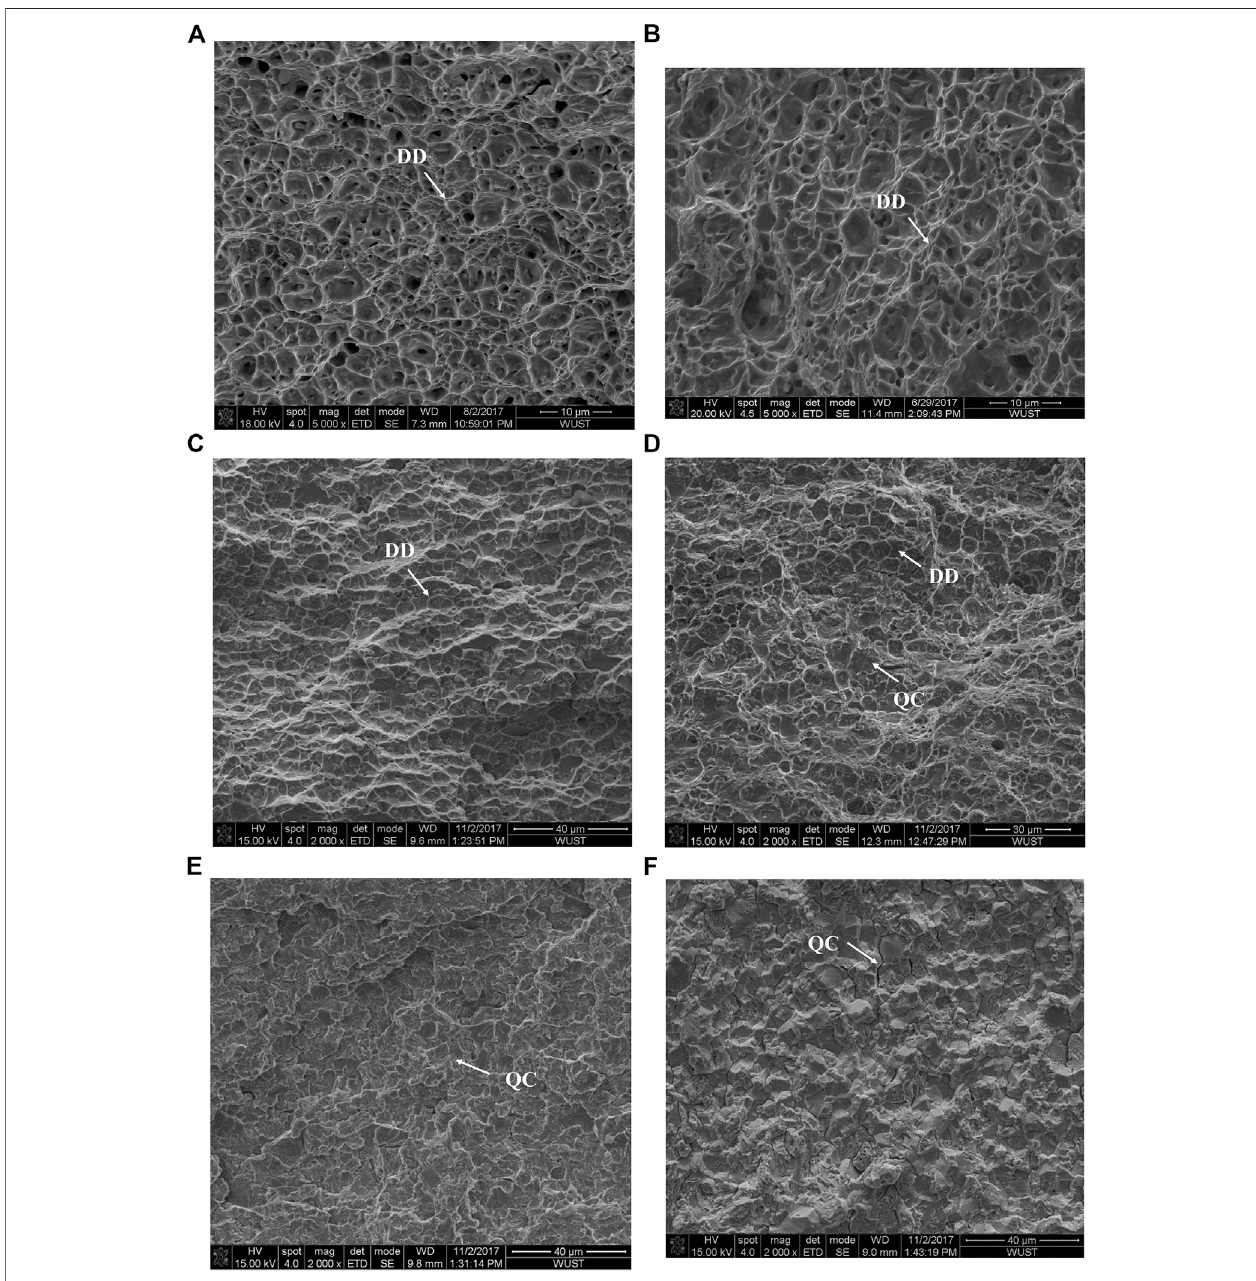
FIGURE 5 | Fracture surface morphologies of DP steels with different martensite content: (A) 18.5% with non-charged; (B) 96.3% with non-charged; (C) 18.5% with H-charged; (D) 46.7% with H-charged; (E) 68.3% with H-charged and (F) 96.3% with H-charged.